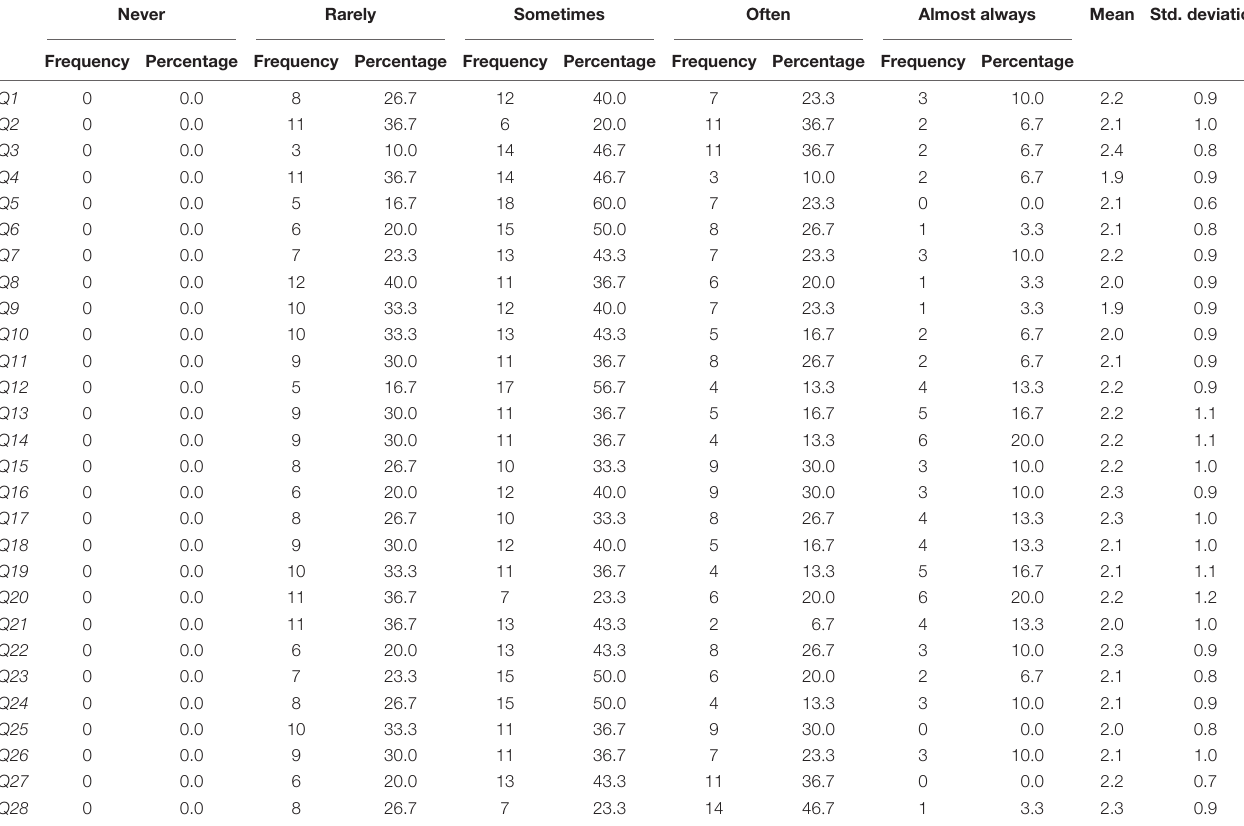
TABLE 4 | Distribution of the responses of the experimental group to the questionnaire after treatment. Never Rarely Sometimes Often Almost always Mean Std.